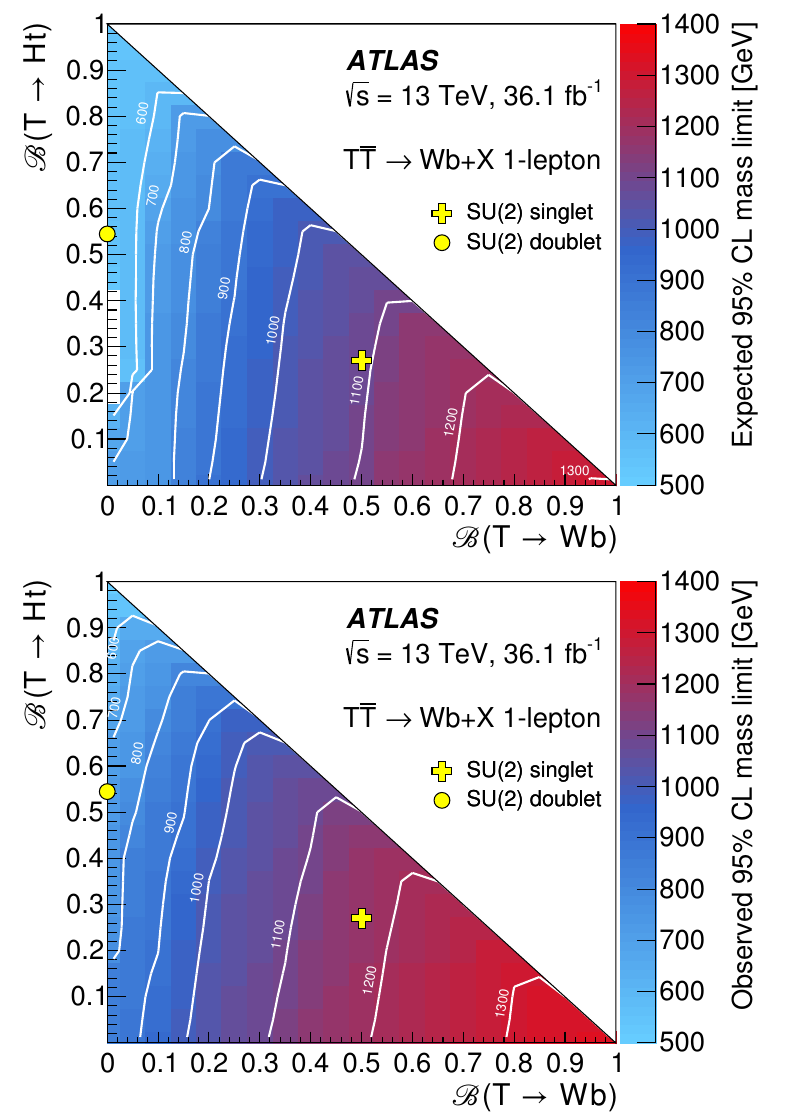
Figure 5 . Expected (top) and observed (bottom) 95% CL lower limits on the mass of the T quark as a function of the decay branching ratios into B ( T ! Wb ) and B ( T ! Ht ). Contour lines are provided to guide the eye. The markers indicate the branching ratios for the SU(2) singlet and doublet scenarios with masses above (cid:24) 0.8 TeV, where they are approximately independent of the VLQ T mass. The white region is due to the limit falling below 500 GeV, the lowest simulated signal